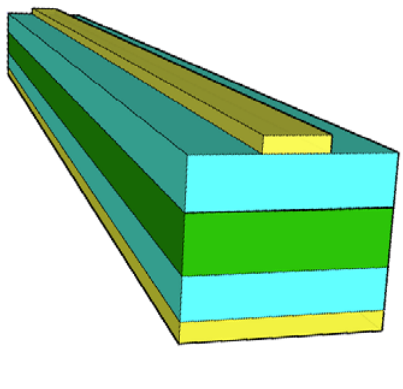
Figure 5. Schematic structure of the Field-Induced Guiding (FIG)—optical layers are not patterned, waveguide is dynamically created by the local filed between two electrodes shown in